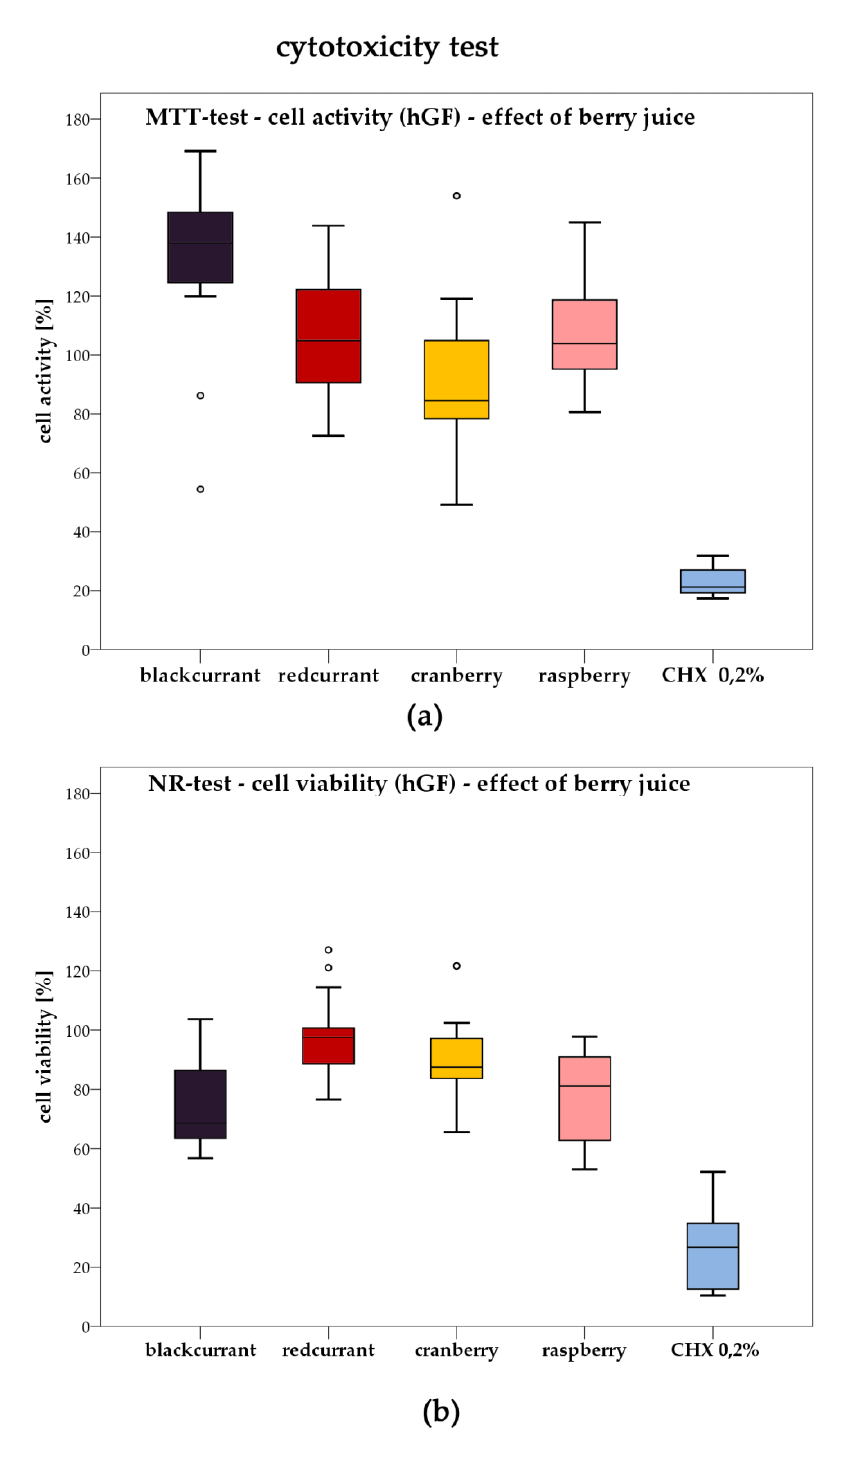
Figure 4. Cytotoxicity of highly concentrated berry juices (90%) after 60 s of incubation on human gingival fibroblasts (hGF); ( a ) cell viability determined by MTT assay, ( b ) cell viability determined by NR assay.